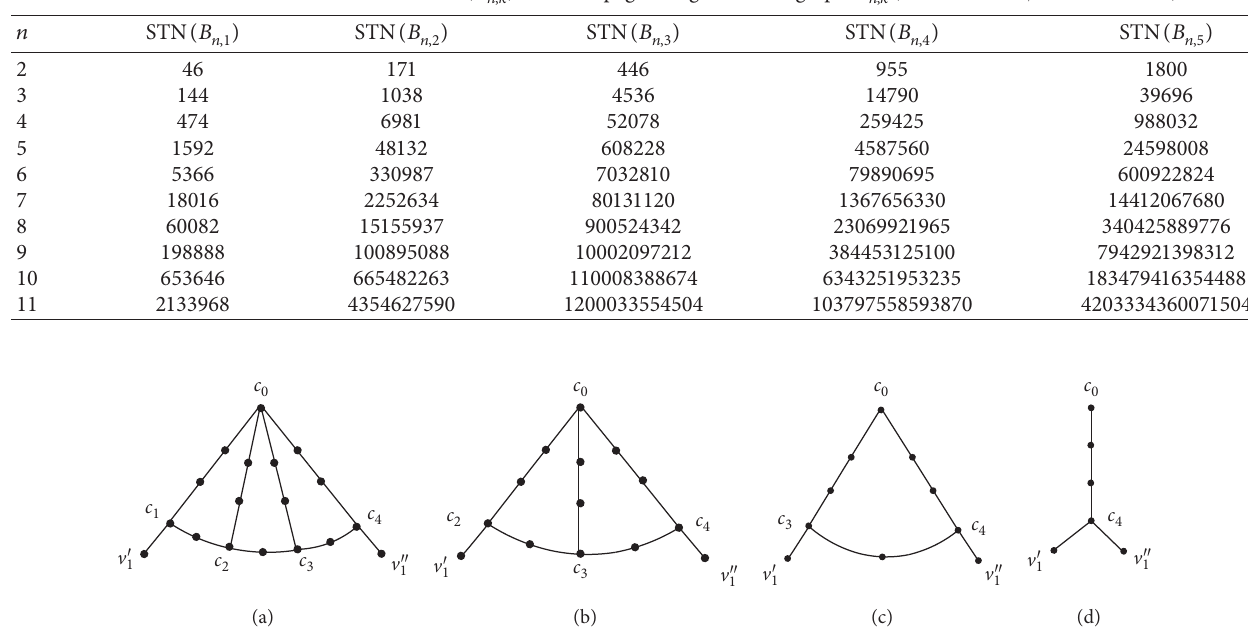
) of the n -page k regular book graph B n,k